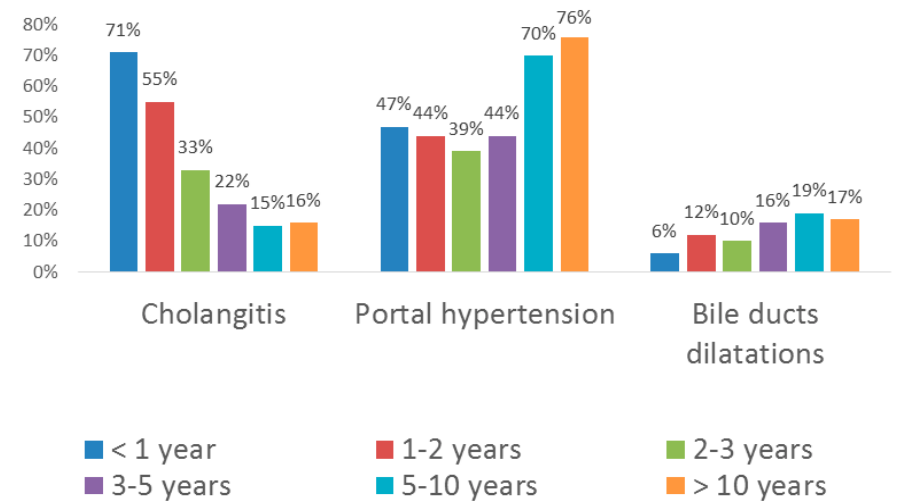
Figure 1. Age-related structure of complications observed in BA patients after Kasai surgery (percent values reflect the proportion of patients affected by the condition, not the number of episodes).